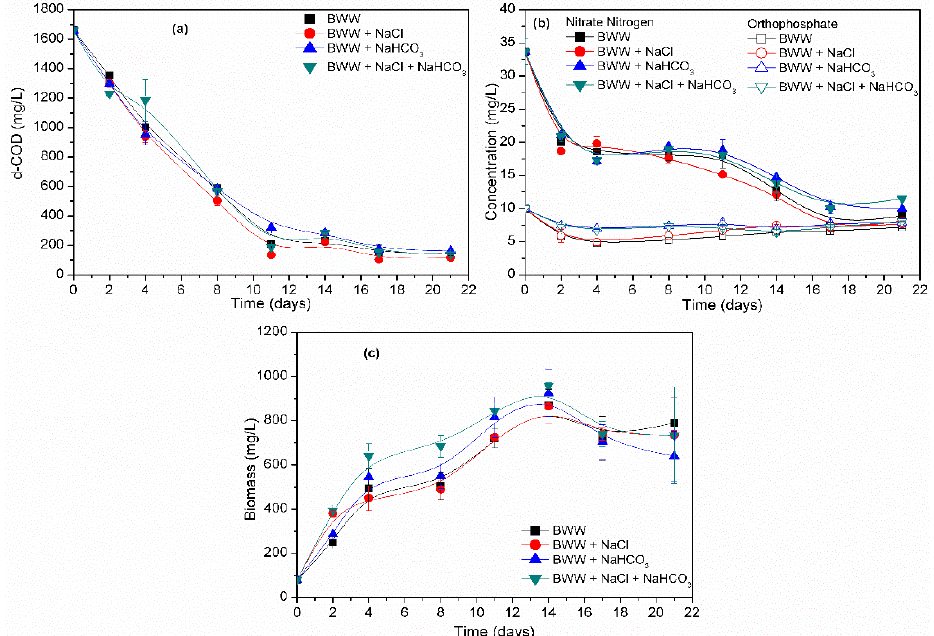
Figure 1. ( a ) d-COD consumption, ( b ) NO 3 − -N and PO 43 − -P consumption, and ( c ) growth of total biomass during A. platensis cultivation under continuous illumination in four different brewery wastewater-based media. Data present mean values of duplicate experiments ± standard deviations.